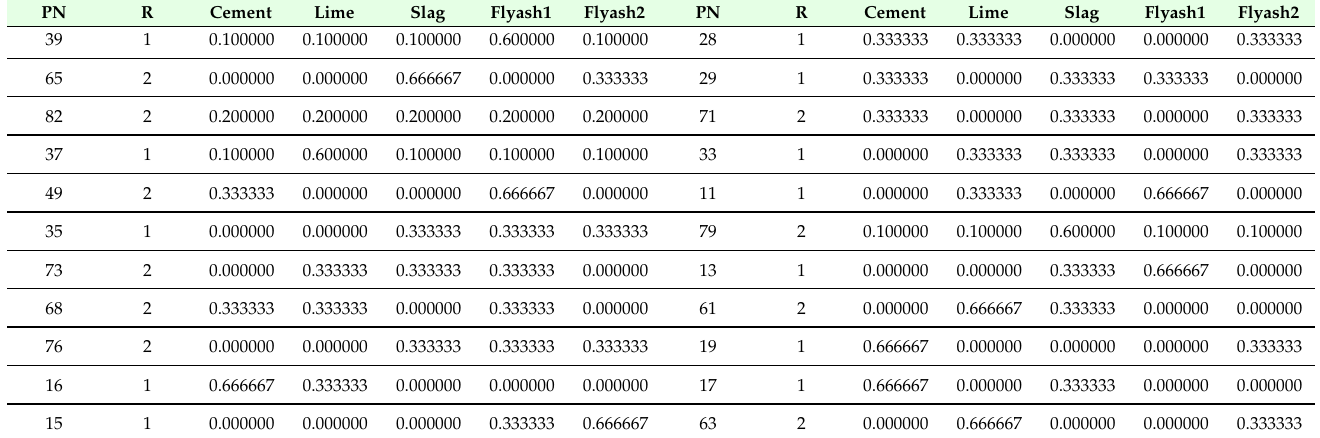
Table A1. Schedule of the recipes for each soil specimen. Replicate 2 is a double